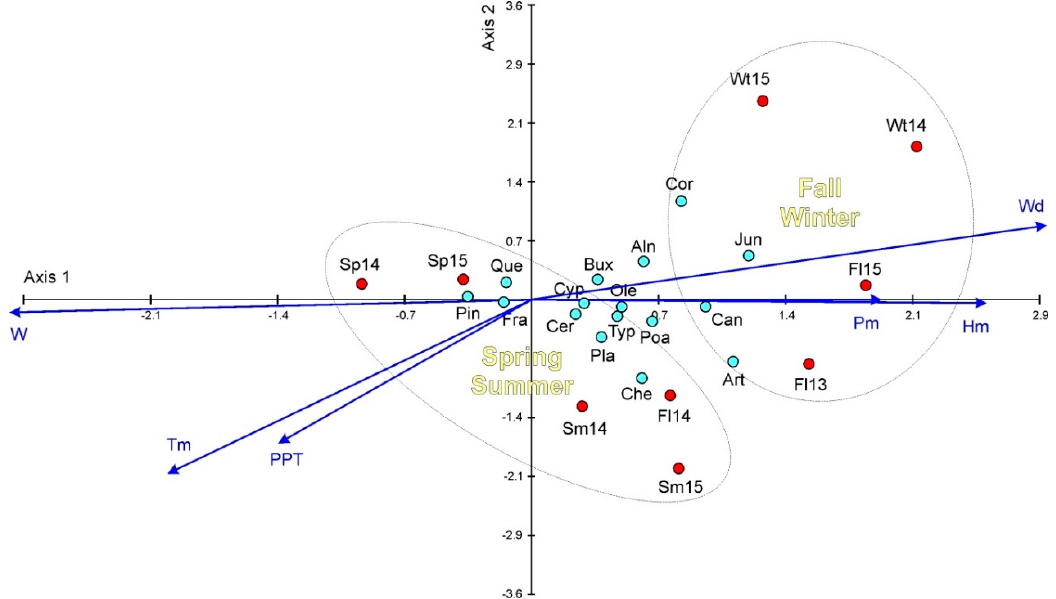
Figure 4. Canonical correspondence analysis (CCA) biplot using the scores of the first two axes accounting for 70.74% of the total variance. Samples are represented by red dots and pollen taxa (for abbreviations see Figure 3) are represented by blue dots. Samples are identified seasonally as follows: Sp—Spring, Sm—Summer, Fl—Fall, Wt—Winter. Meteorological parameters are abbreviated as in Figure 3: Tm—average temperature, Hm—average relative humidity,